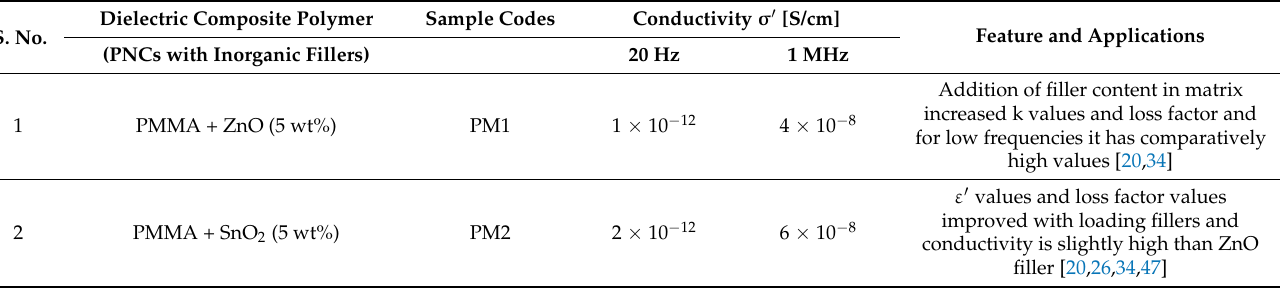
Table 2. Polymer composite films with conductivity values and